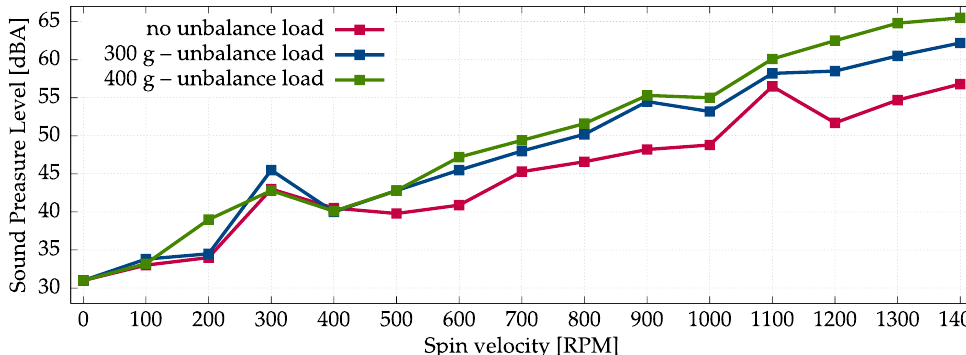
Figure 2. Sound Pressure Level measured at the M1 location using a certified sonometer.